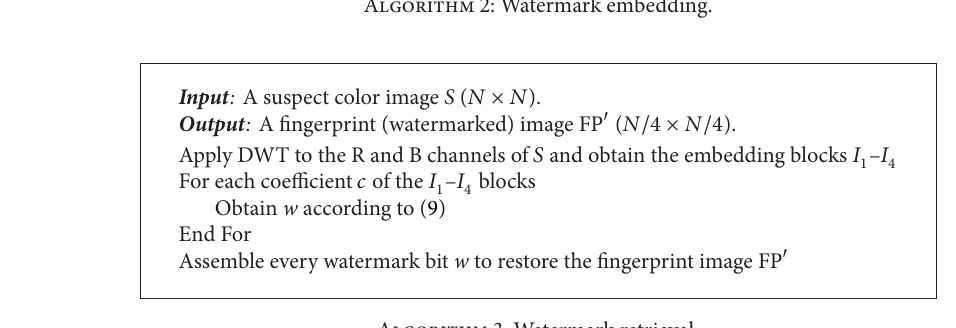
Algorithm 3: Watermark retrieval.